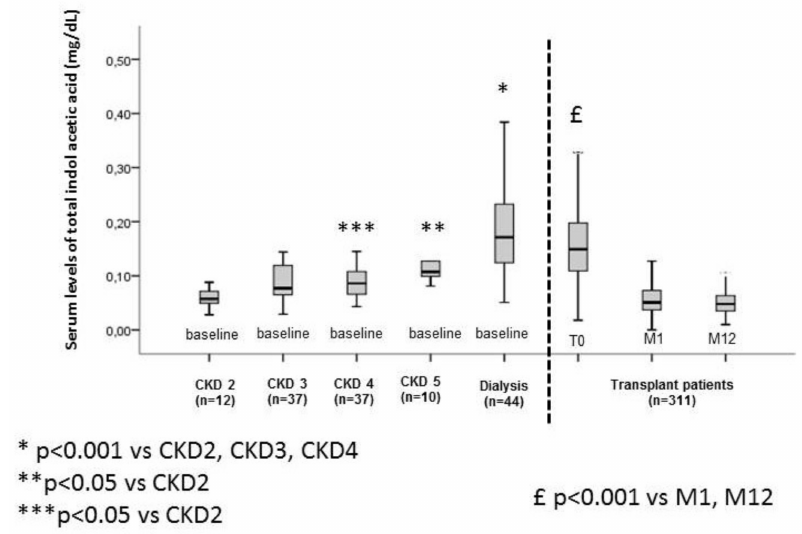
Figure 2. Serum levels of total indole acetic acid in a non-transplanted CKD cohort and a transplanted cohort. Boxplot with whiskers with maximum 1.5 interquartile